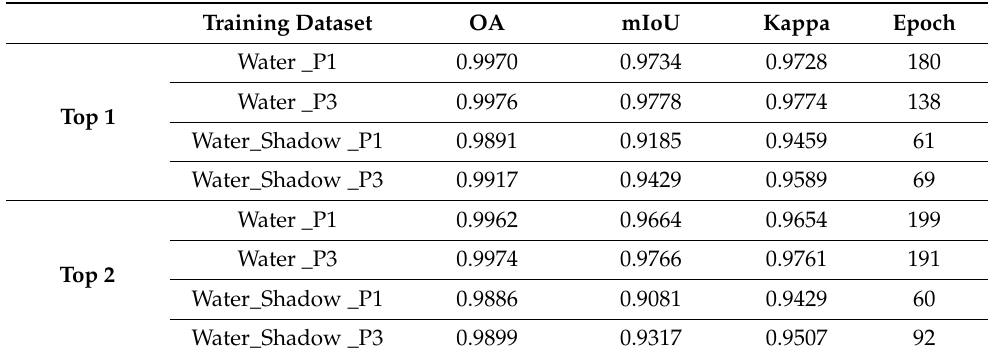
Table 2. Results of accuracy